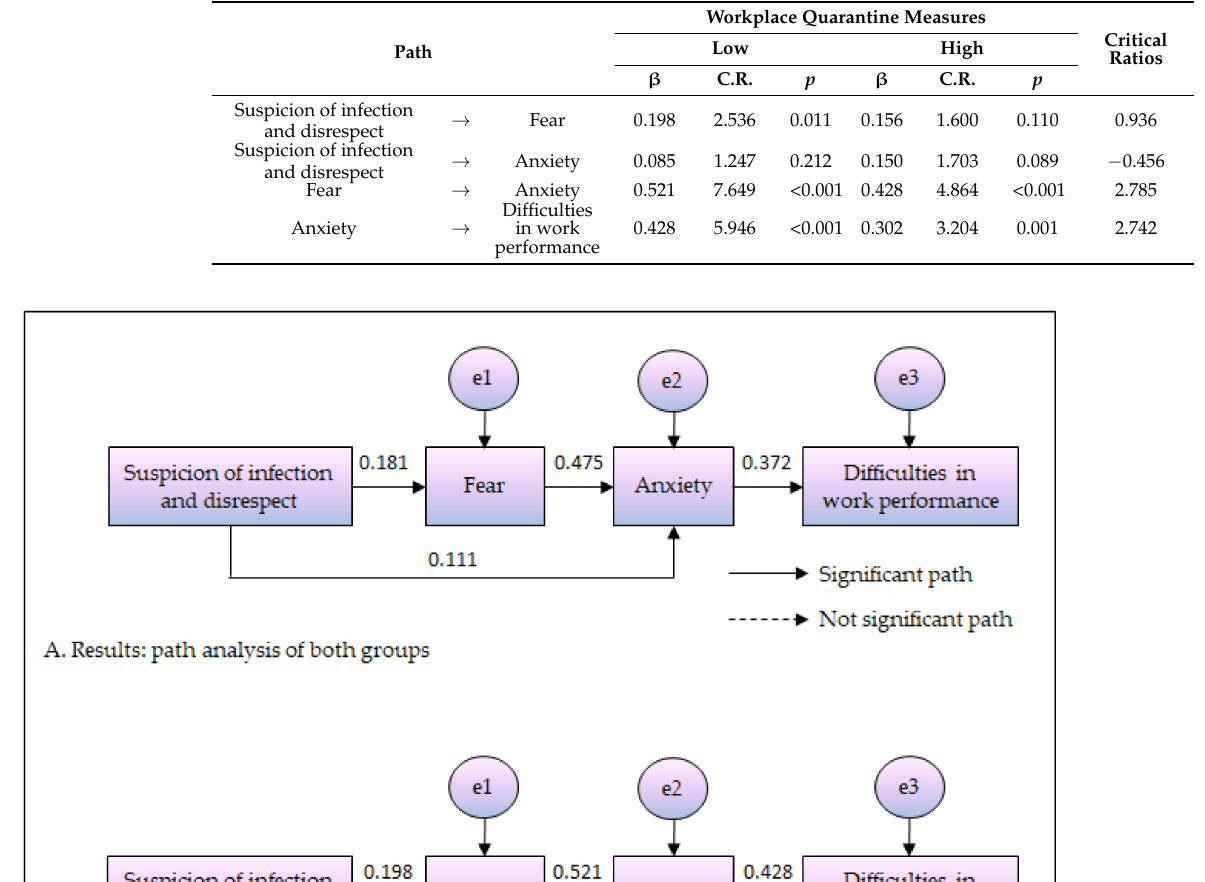
Table 4. Result of Path analysis according to Workplace quarantine measures.